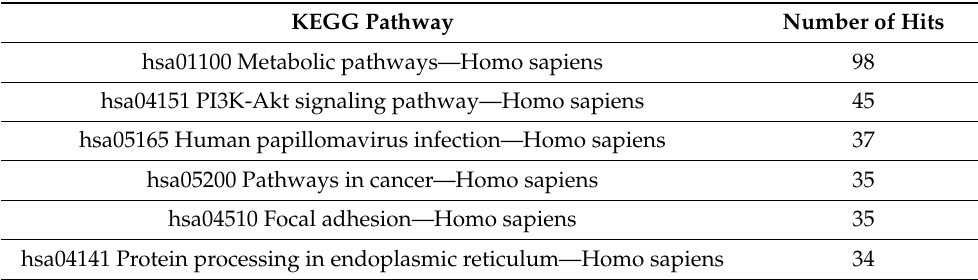
Table 5. KEGG pathway analysis using all 1241 DEGs upregulated by hypoxia. KEGG